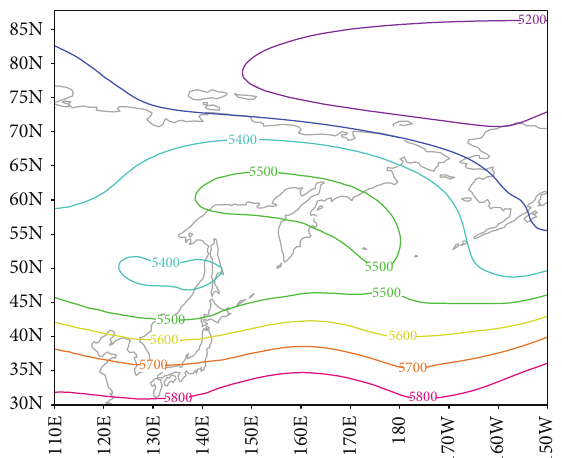
Figure 3: GEFS control time averaged geopotential heights for October 11–19, 2012.